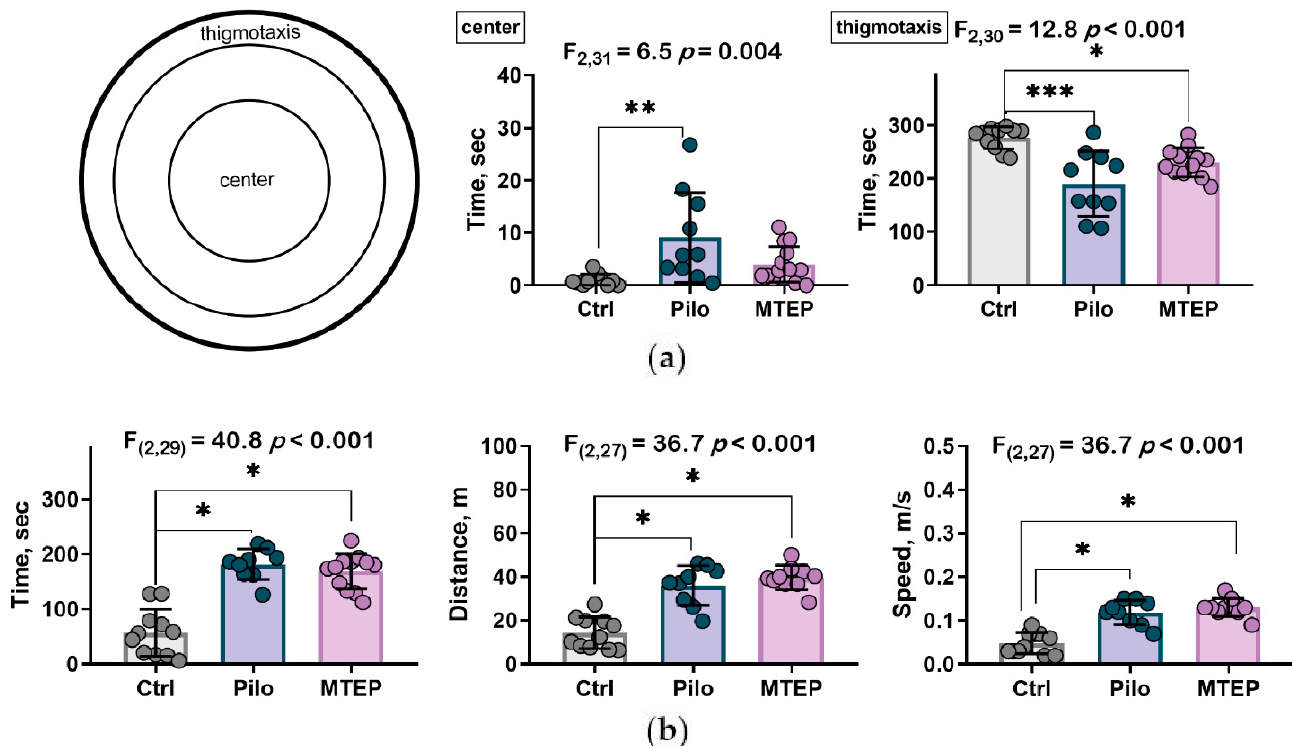
Figure 11. Open field test. ( a ) Distribution of time spent in center and thigmotaxis areas of the open field. ( b ) Locomotion characteristics in the open field test. * p < 0.05, ** p < 0.01, *** p < 0.01 in one-way ANOVA with Tukey’s post hoc test.